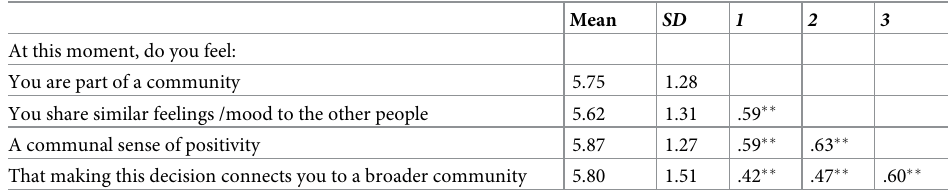
Table 5. Means ( SD ), and Pearson Product-Moment correlations for four community items.